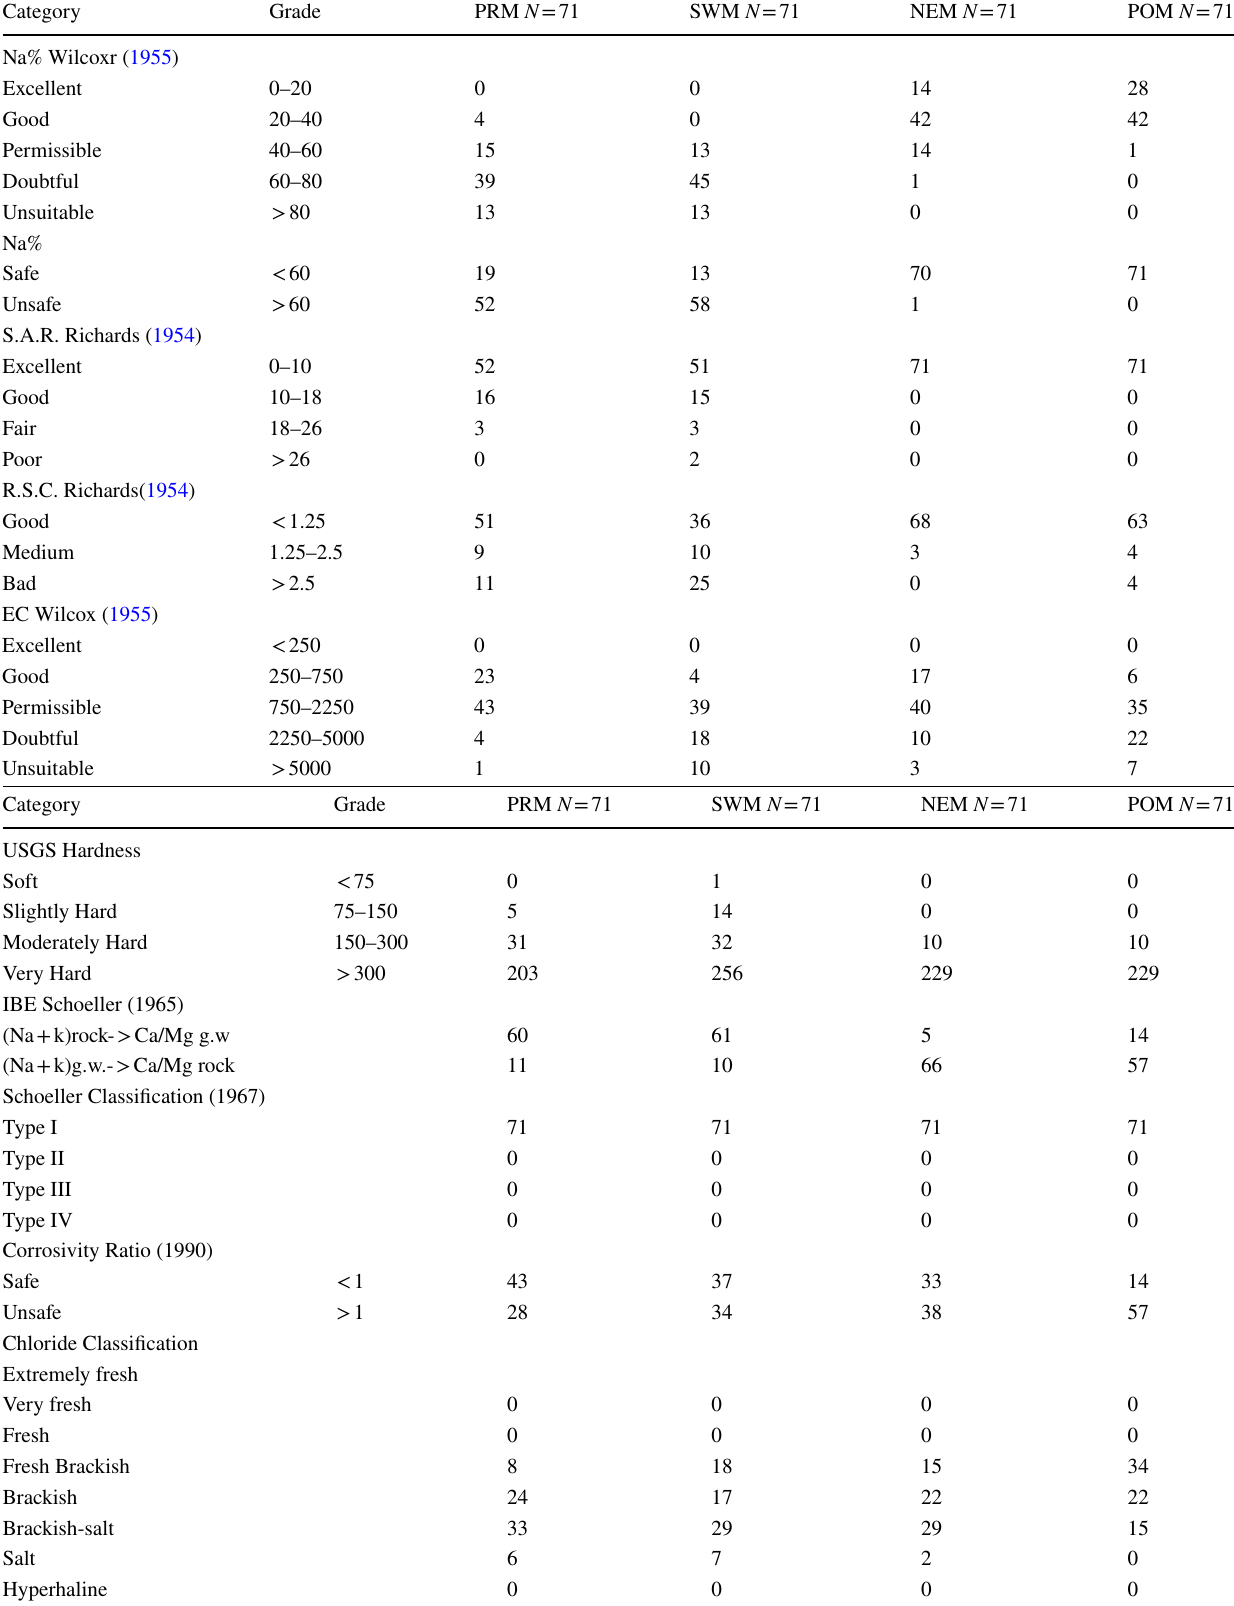
Table 6 Summary of Geochemical classification by WATCLAST Program for all four seasons (Chidambaram 2000)